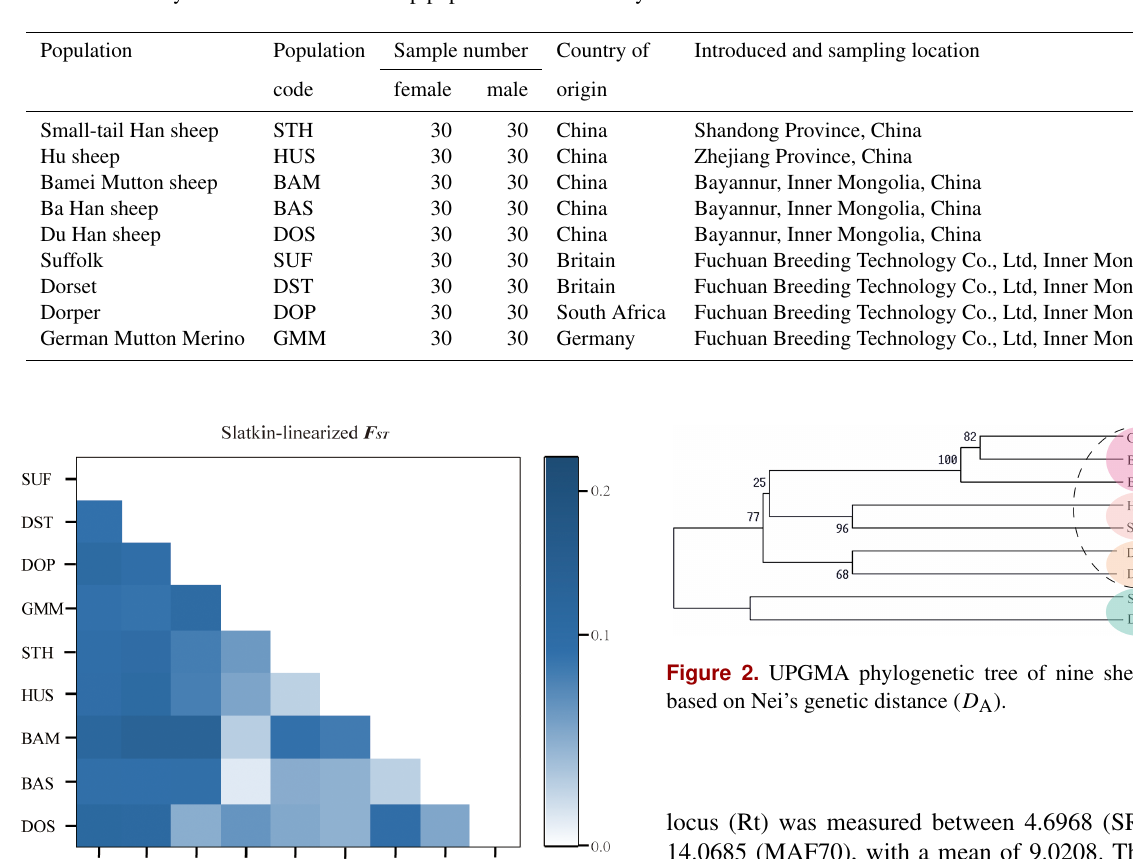
Table 1. Summary information of nine sheep populations in this study.